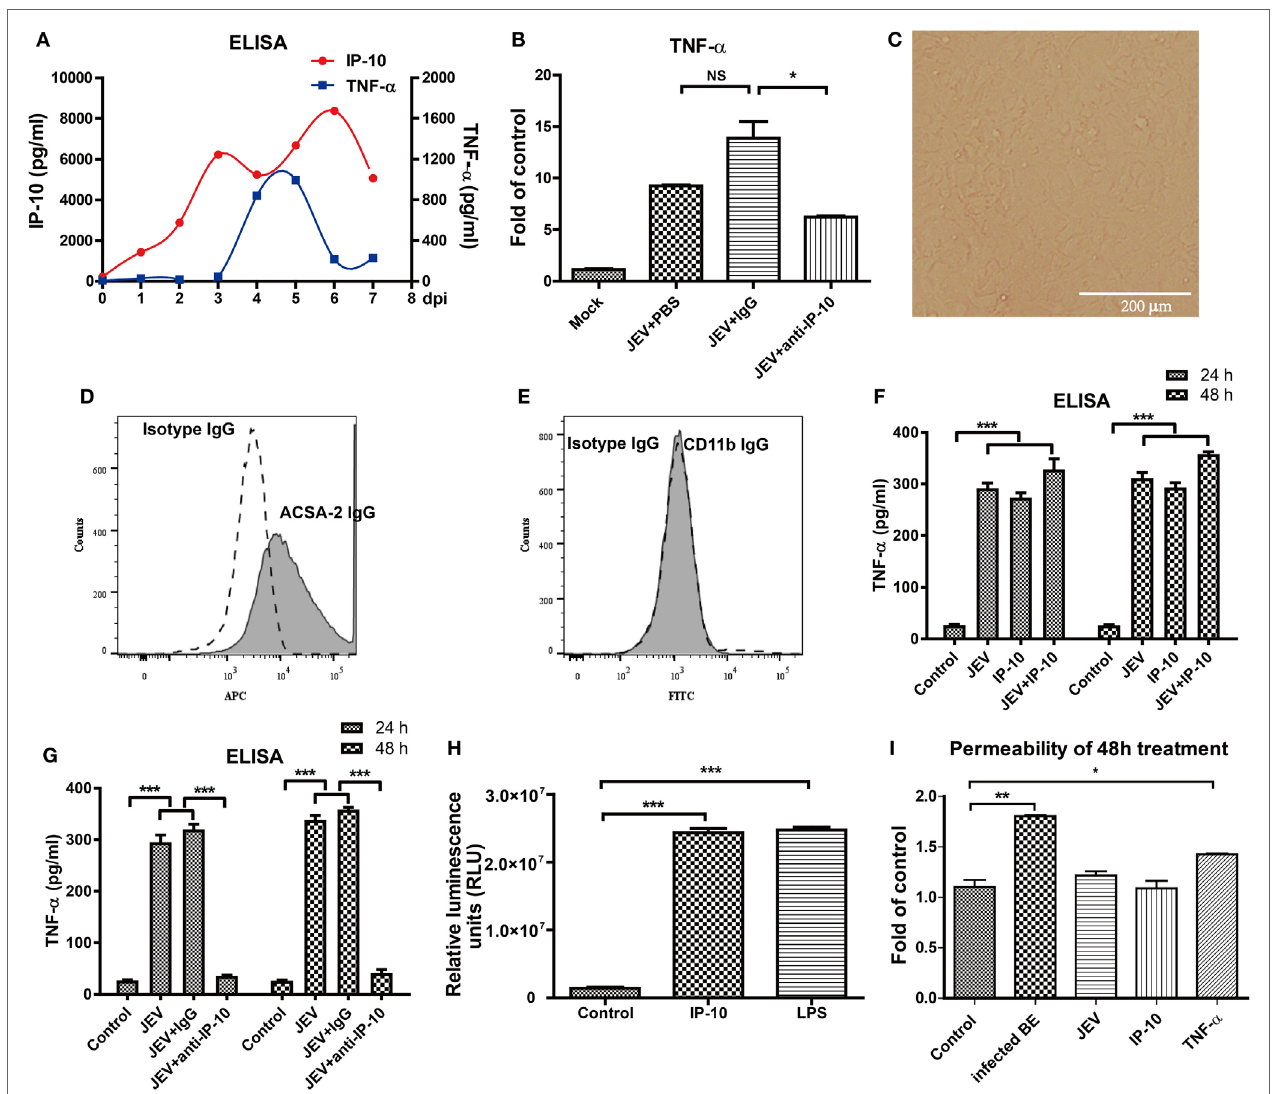
FigUre 5 | Tumor necrosis factor alpha (TNF- α ) expression in vivo and in vitro . (a) IP-10 and TNF- α expression levels in the brain tissues of Japanese encephalitis virus (JEV)-infected mice from day 0 to day 7 were determined by enzyme-linked immunosorbent assay (ELISA) ( n = 4). (B) mRNA level of TNF- α in mouse brains after anti-IP-10-neutralizing antibody, isotype antibody, or PBS treatment. (c) The confluent monolayer of astrocytes was observed under a light microscope. (D,e) Astrocytes were stained with isotype IgG and IgG against ACSA-2 or CD11b. The populations of astrocytes were detected using a BD FACSCalibur flow cytometer. (F) The TNF- α levels in the supernatants of astrocytes treated with IP-10 (200 ng/ml) or JEV at 24 and 48 h were measured with ELISA. (g) TNF- α expression in IP-10-neutralizing antibody-treated astrocytes at 24 and 48 h after JEV infection. (h) TNF- α luciferase plasmid was transfected into HEK 293T cells, and the luciferase activity was measured after lipopolysaccharide (LPS) (1,000 ng/ml) or IP-10 (200 ng/ml) treatment. (i) The transendothelial permeability of bEnd.3 monolayers was measured with dextran-FITC after 48 h of treatment with BE, JEV (5 MOI), IP-10 (200 ng/ml), or TNF- α (100 ng/ml). The data are expressed as the means ± SEMs of the results from three independent experiments. * p < 0.05; ** p < 0.01; *** p <